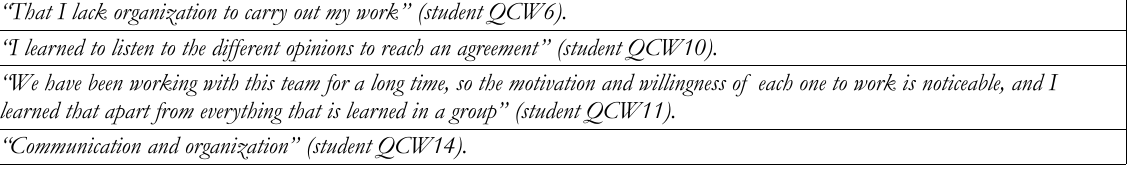
Table 7. Open comments from the students through the questionnaire on cooperative learning,